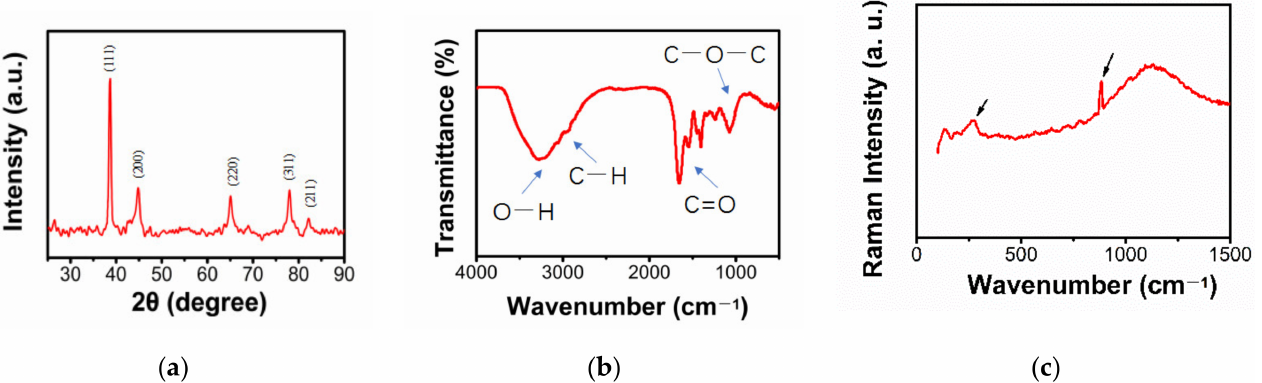
Figure 2. ( a ) XRD pattern of obtained AuNPs@Chlorella. ( b ) FTIR results of AuNPs@Chlorella synthesized. ( c ) Raman spectra of the biostabilized colloidal